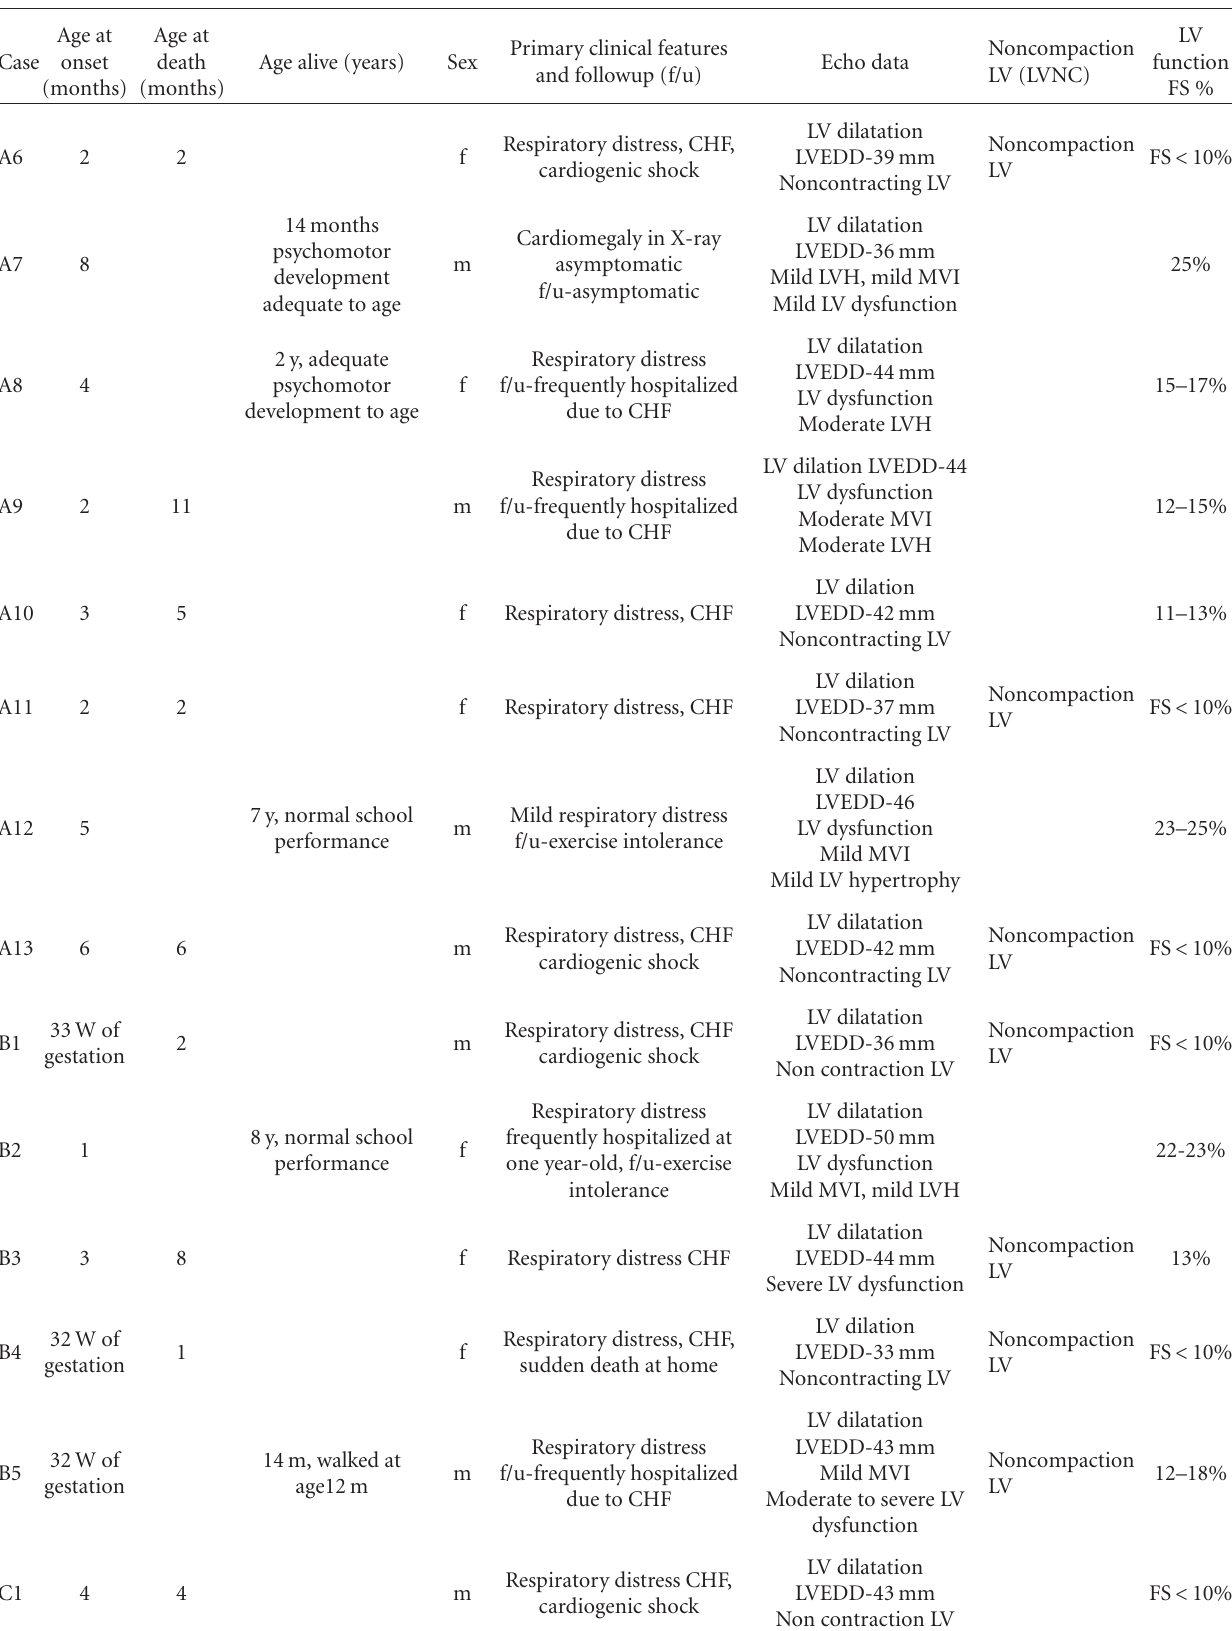
Table 2: Clinical data of the patients with the G555E mutation in the SDHA